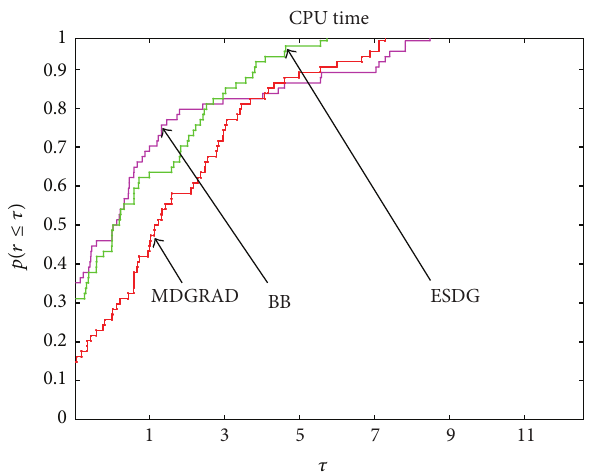
Figure 2: Performance profile based on CPU time per